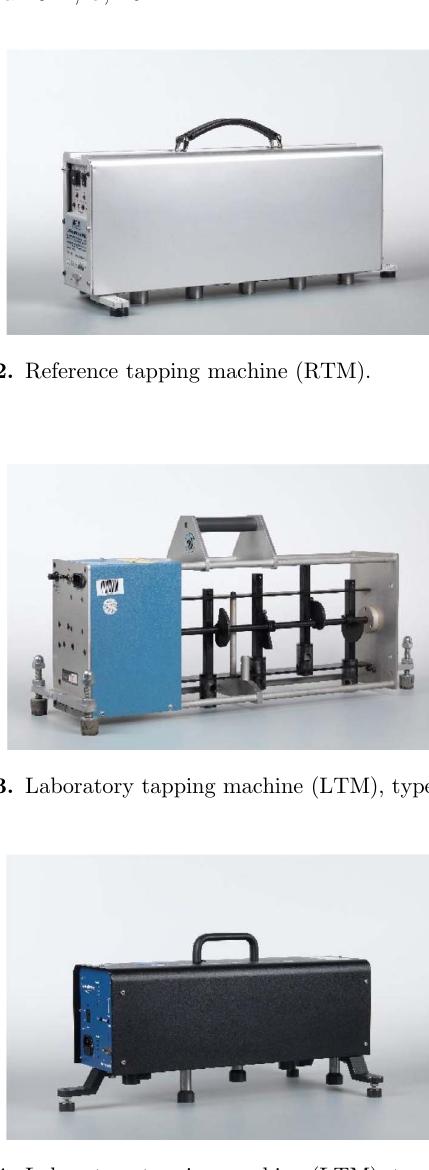
Figure 4. Laboratory tapping machine (LTM), type